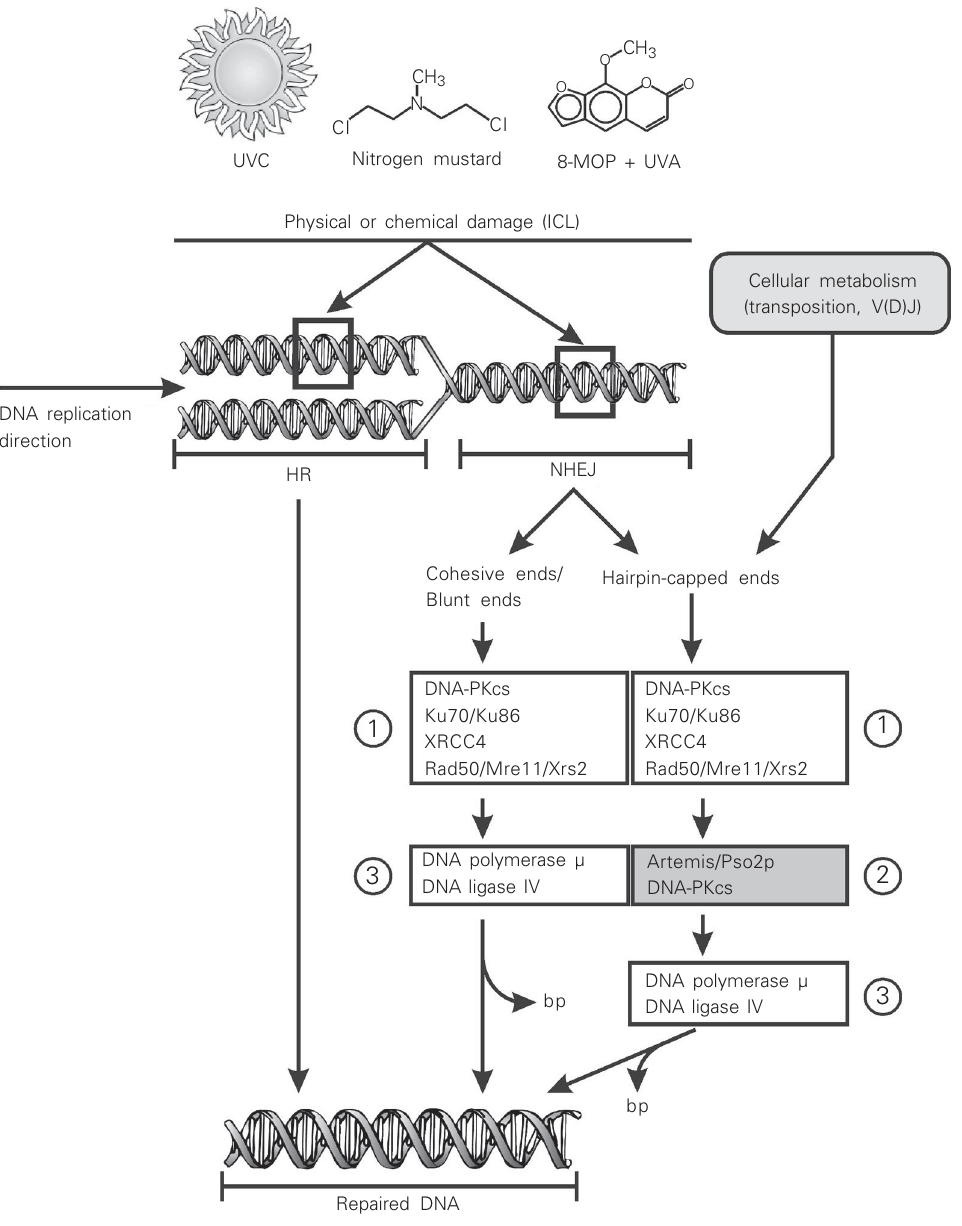
Figure 1. Schematic drawing of double-strand break (DSB) re- pair in mammalian cells. DSB induced by inter-strand cross- link (ICL) generated by physical agents (UVC), chemical sub- stances (nitrogen mustard, 8- MOP + UVA), or even cellular metabolism (gray box) on DNA during replication can be re- paired by two biochemical path- ways: homologous recombina- tion (HR) or non-homologous end joining (NHEJ). HR is the major DNA repair pathway used when two homologous DNA strands are present. NHEJ is used when the homologous DNA strand is not present. The protein complexes that are used for NHEJ repair depend on the type of DNA ends present in the DSB (cohesive ends, blunt ends, or hairpin-capped ends). Protein complexes 1 and 3 re- pair both cohesive and blunt ends, while hairpin-capped ends are repaired by Artemis/ Pso2p/DNA-PKcs (complex 2). The final result is the restitution of high molecular weight DNA, with loss (NHEJ) or without loss (HR) of DNA base pairs (bp). UVC = UV 254 nm ; 8-MOP + UVA = 8-methoxypsoralen plus UVA; UVA = UV 365 nm ; DNA-PKcs = DNA-dependent protein kinase catalytic